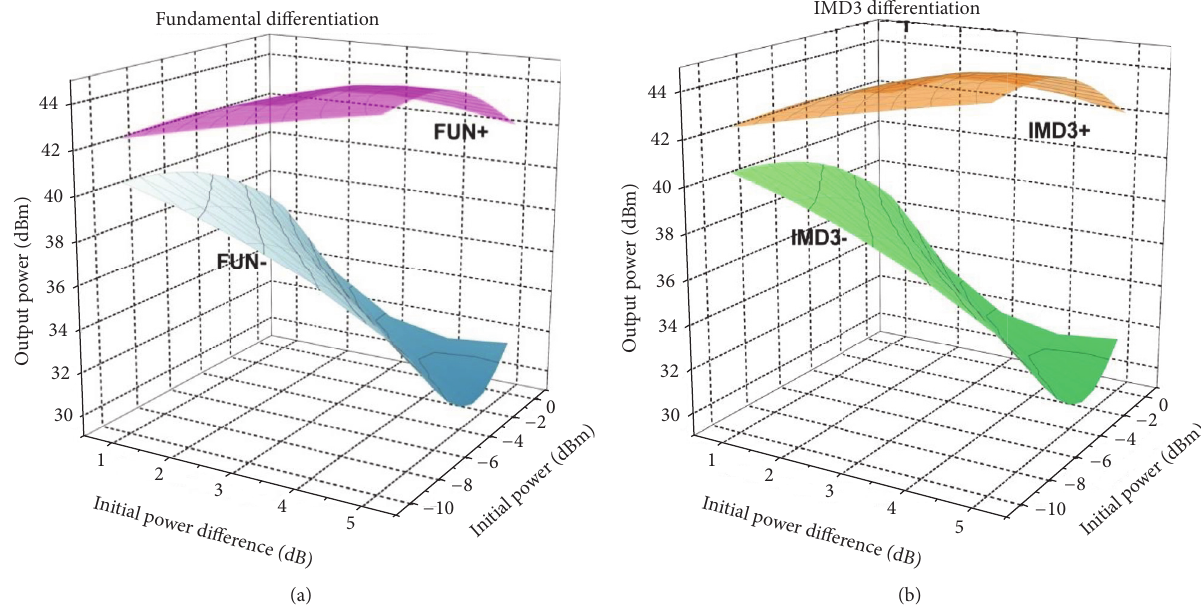
Figure 3: (a) 3D plot of fundamental differentiation; (b) 3D plot of IMD3 differentiation according to initial power and power difference.